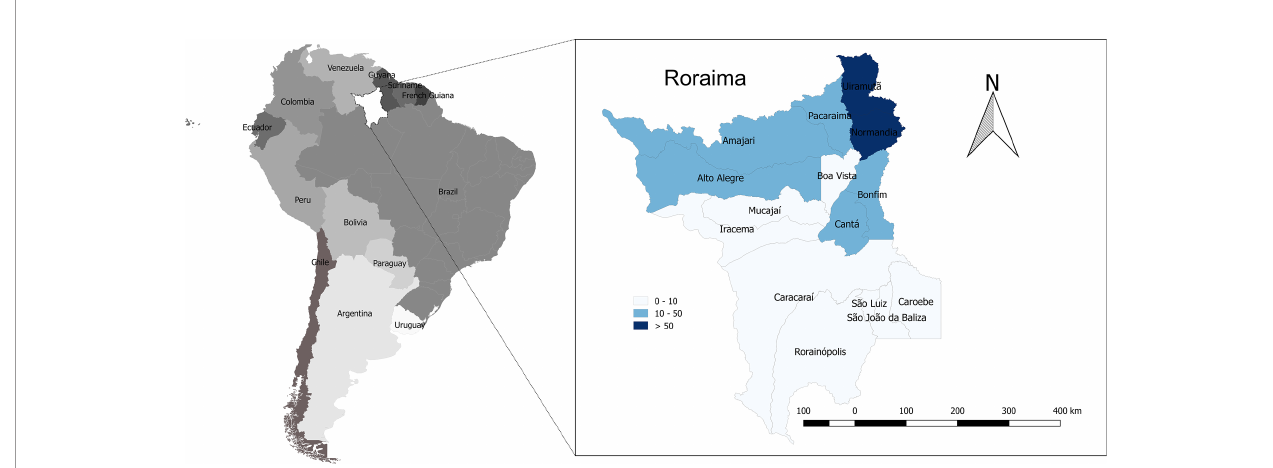
FIGURE 3 | Geographic and temporal distribution of Crotalus durissus ruruima snakebites in the state of Roraima, Brazilian Amazon. Incidence rate per municipality (cases/100,000 inhabitants/year, showing a higher incidence in the north of the